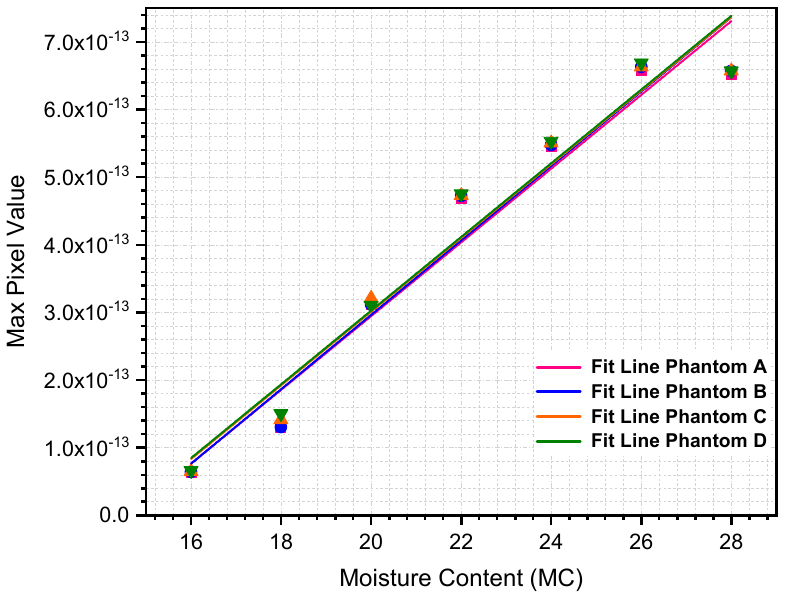
Figure 6. Percentage of maximum pixel value using Tikhonov Regularization algorithm.